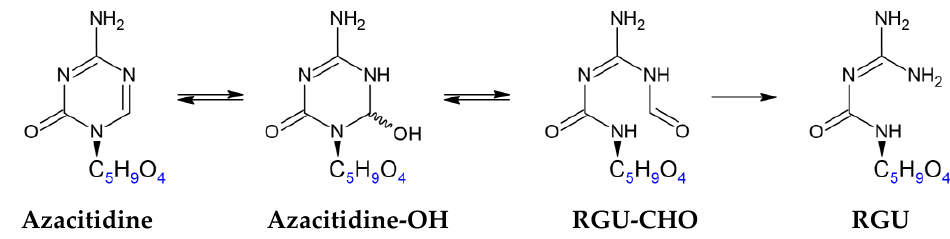
Figure 2. Three RGU tautomeric forms.